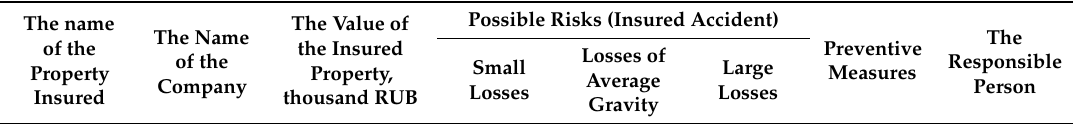
The intracompany ledger of the connection between the segments of activity and responsibility